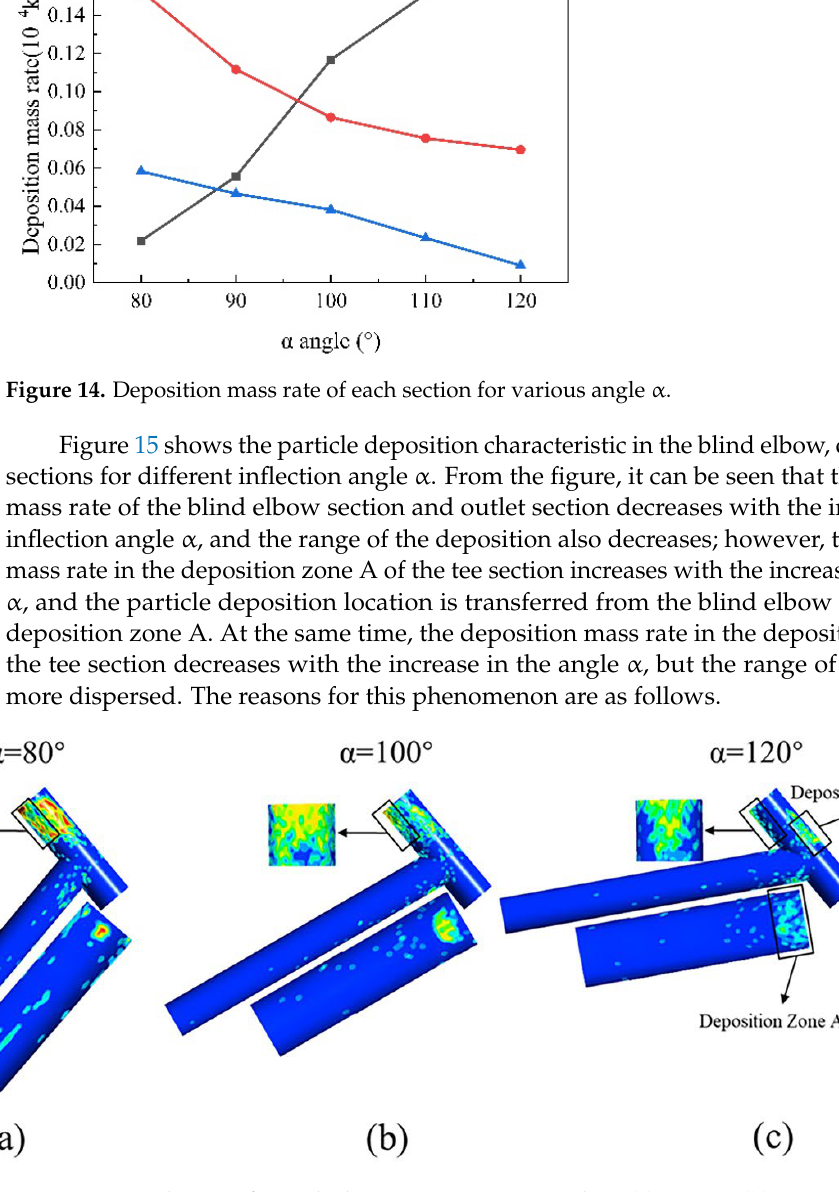
Figure 15. Distribution of particle deposition at various angle α. ( a ) α = 80°; ( b ) α = 100°; ( c ) α = 120°. Firstly, with the increase in the inflection angle α, the amount of furnace gas flowing into the blind elbow section gradually decreases, which leads to the decrease in the pressure of the blind elbow section from 106 Pa to 34 Pa. This conclusion can be reflected by the pressure distribution diagram of the blind elbow section as shown in Figure 16. Therefore, the number of particles entering the blind elbow section also decreases, and a large number of particles flow directly into the flue outlet section with the mainstream furnace gas, as shown in Figure 17. Figure 17a shows that the collision zone of particles with the flue wall can be predicted based on the trajectory of the particles. As the angle α increases, the collision zone between the particles and the wall in the blind elbow section is shrinking, causing the range of the deposition zone to decrease correspondingly. In addition, the number of particles flowing into the blind elbow section decreases with the